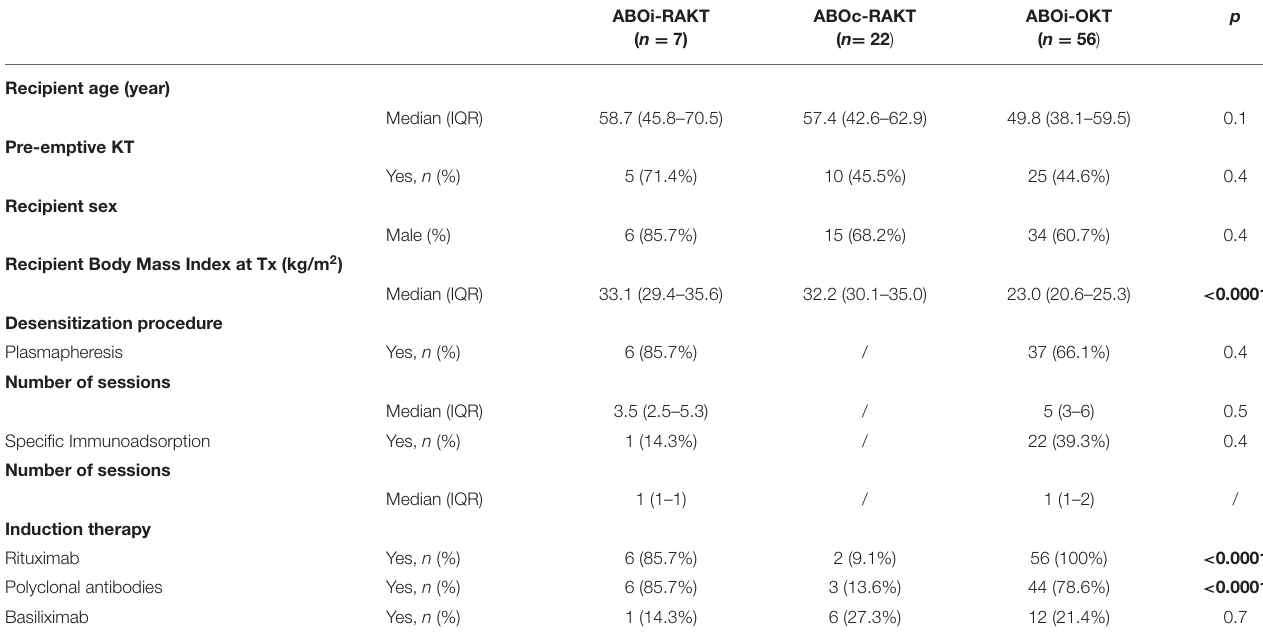
TABLE 1 | Patients’ characteristics and desensitization protocols.